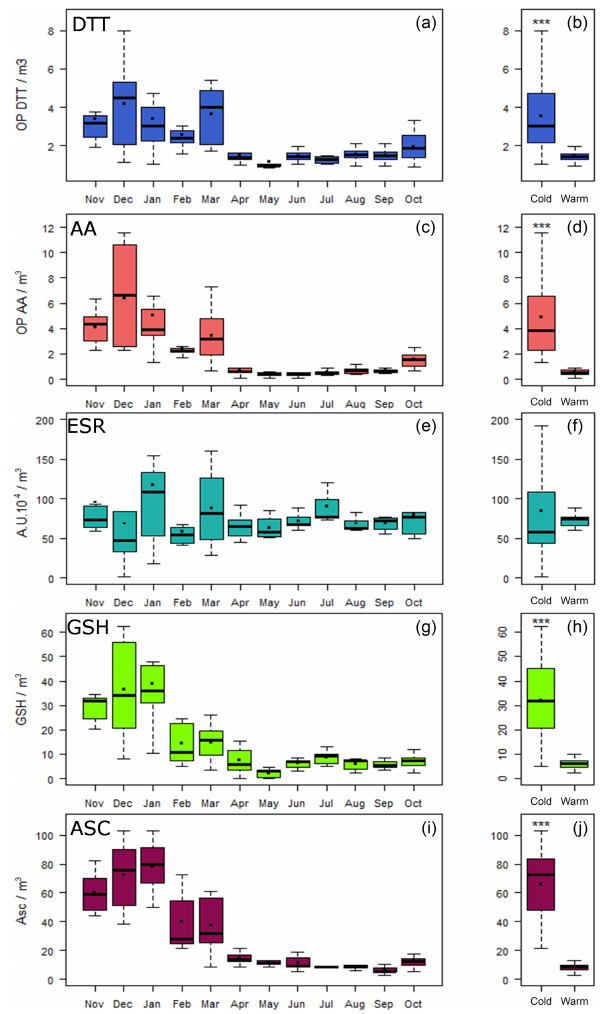
Figure 2. Seasonal variation of the five OPv ( a , OP DTT; c , OP AA; e , ESR; g , OP GSH; i , OP ASC) and OPv differences between cold and warm periods ( b , OP DTT; d , OP AA; f , OP ESR; h , OP GSH; j , OP ASC). Boxplot representations with medians (horizon- tal line) and means (black square). ∗∗∗ p < 0 . 001; nonparametric Mann–Whitney